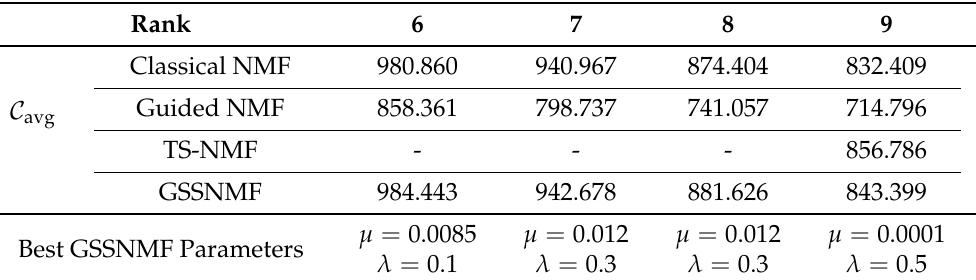
Table 5. Coherence of topics generated by Classical NMF, Guided NMF, TS-NMF, and GSSNMF for 20 Newsgroups